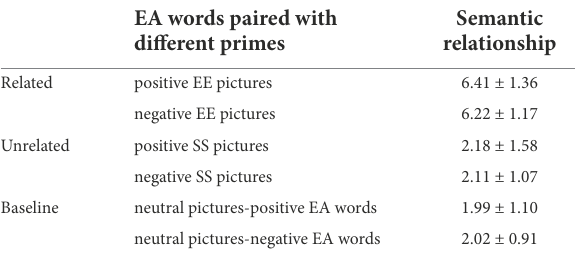
TABLE 3 The rating scores of semantic relationships between prime pictures and EA words. EA words paired with different primes